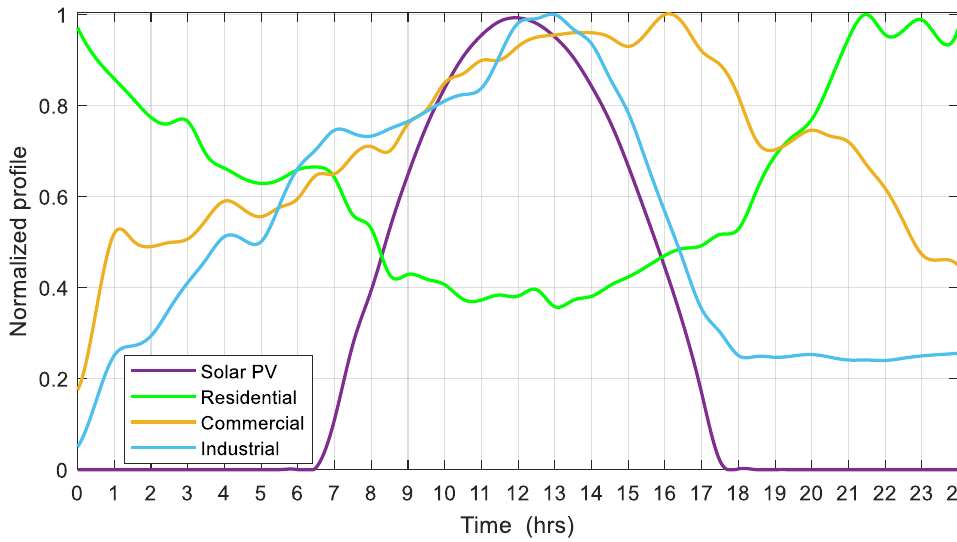
Figure 5. Normalized photovoltaic (PV) generation and load consumption profiles.